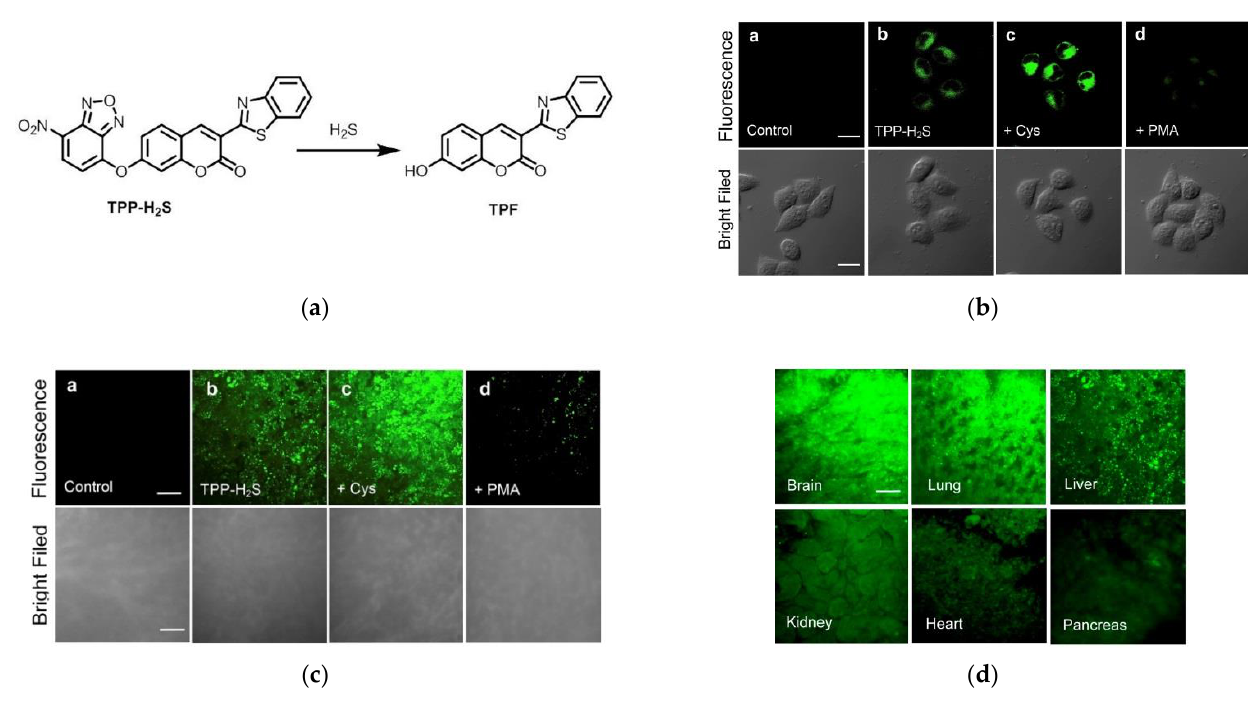
Figure 27. ( a ) Response mechanism of TPP-H 2 S to H 2 S; ( b ) Two-photon confocal microscopy fluo- rescence images of endo-H 2 S in living HeLa cells; ( c ) Two-photon confocal microscopy fluorescence images of fresh liver slices; ( d ) Two-photon confocal microscopy fluorescence images of different viscera slices. Reproduced with permission from [11]. Copyright 2015 Elsevier